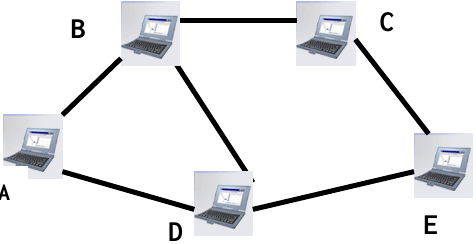
Figure 1: Representation of a Mobile ad- hoc